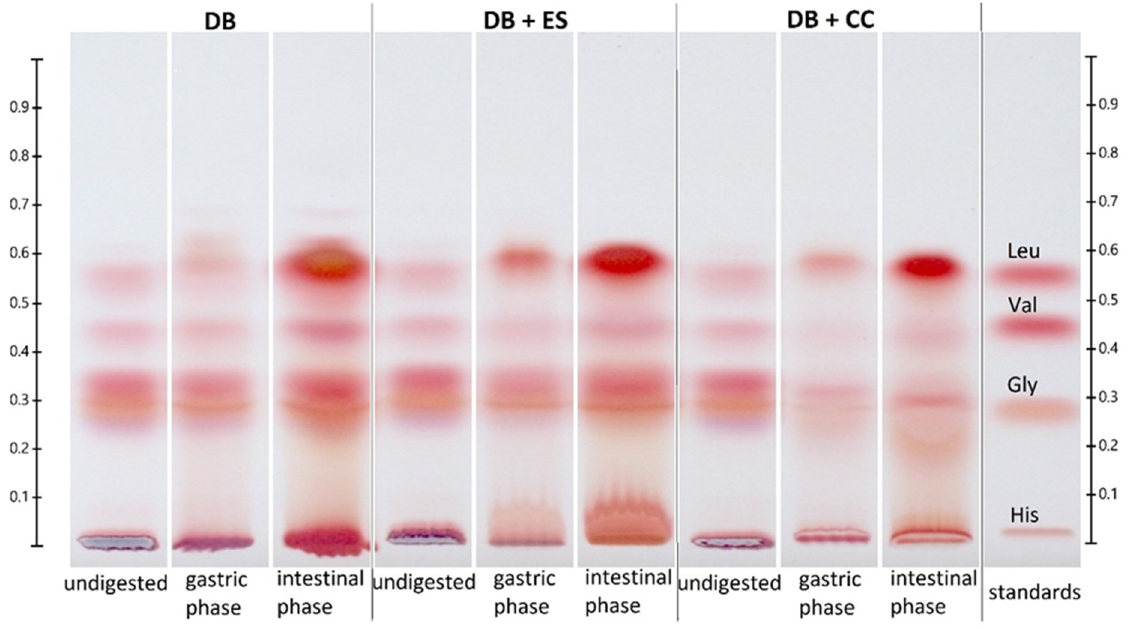
Figure 4. Increase in free amino acids in drone brood (DB) and designed supplements (DB + ES and DB + CC) during in vitro digestion. DB + CC) during in vitro